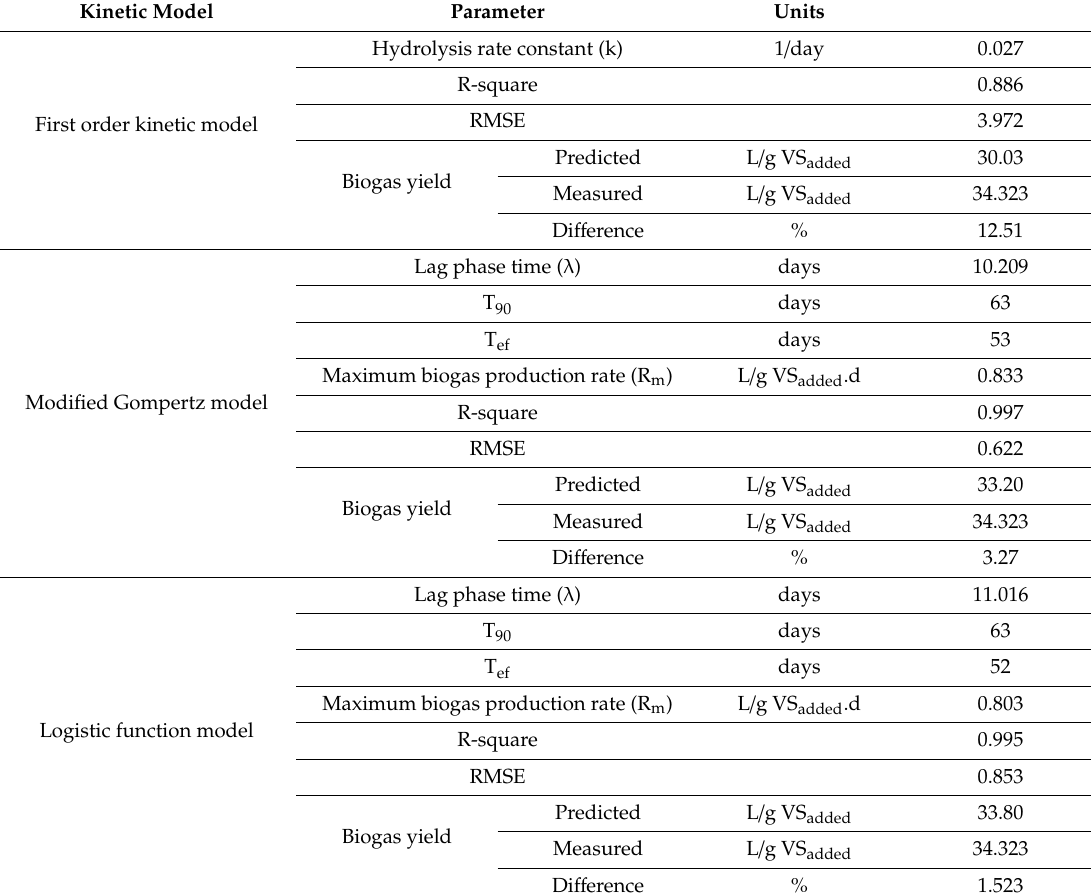
Table 5. Estimated kinetic parameters for the three